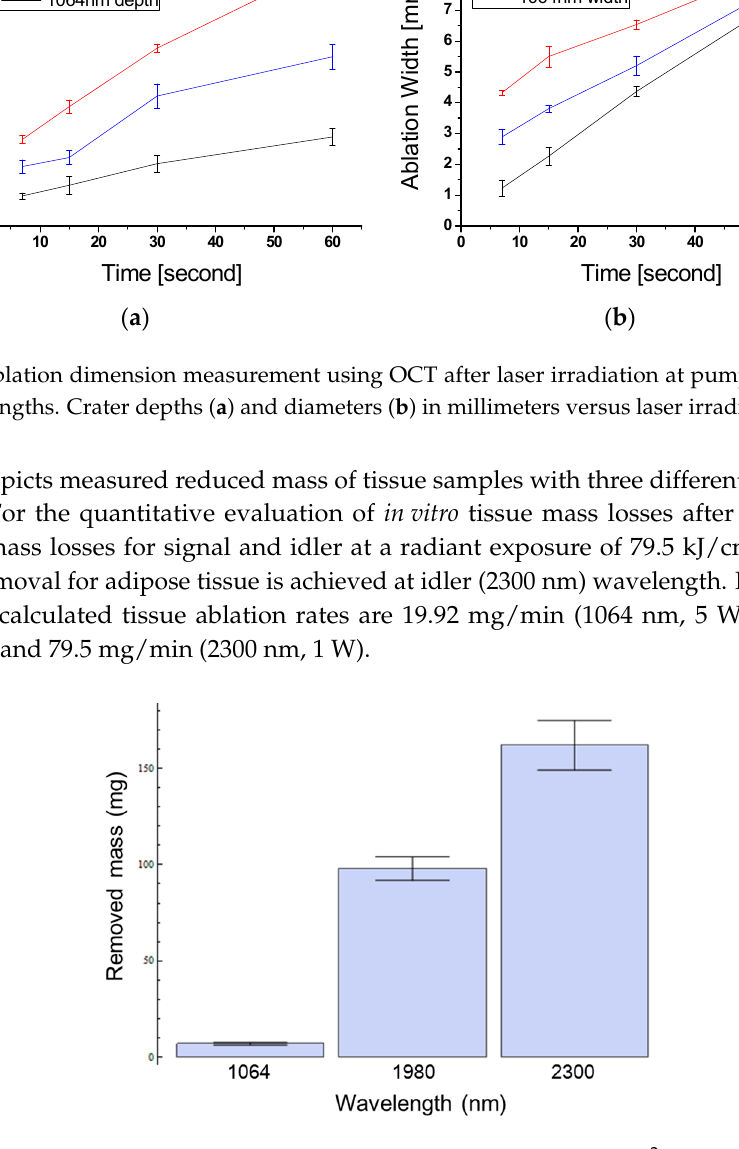
Figure 7. Amount of phase changed masses after laser irradiation at 79.5 kJ/cm 2 for pump, signal, and idler (1064, 1980, and 2300 nm).